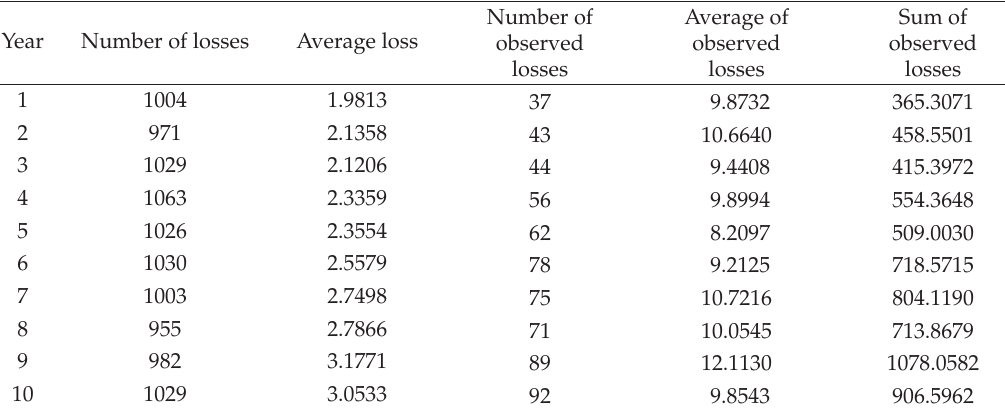
Figure 1: Box-and-whisker plots of all loss amounts (cid:2) a (cid:3) and observed loss amounts (cid:2) b (cid:3) . Table 1: Summary of simulated loss